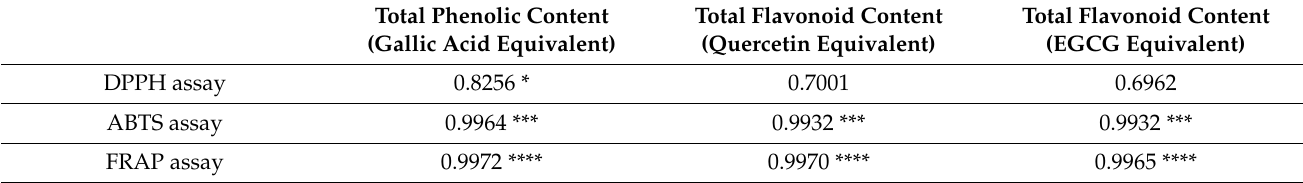
Table 2. Pearson correlation coefficients of total phenolic and flavonoid contents and antioxidant activities of B. flabellifer male flower ethanolic extract measured by DPPH, ABTS, and FRAP assays. Total Phenolic Content Total Flavonoid (Gallic Acid Equivalent)